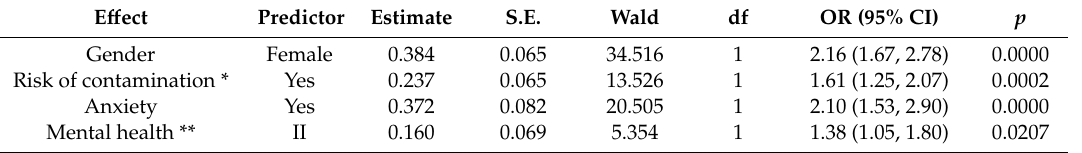
Table 6. Prediction of temporomandibular disorders (TMD) in Poland. E ff